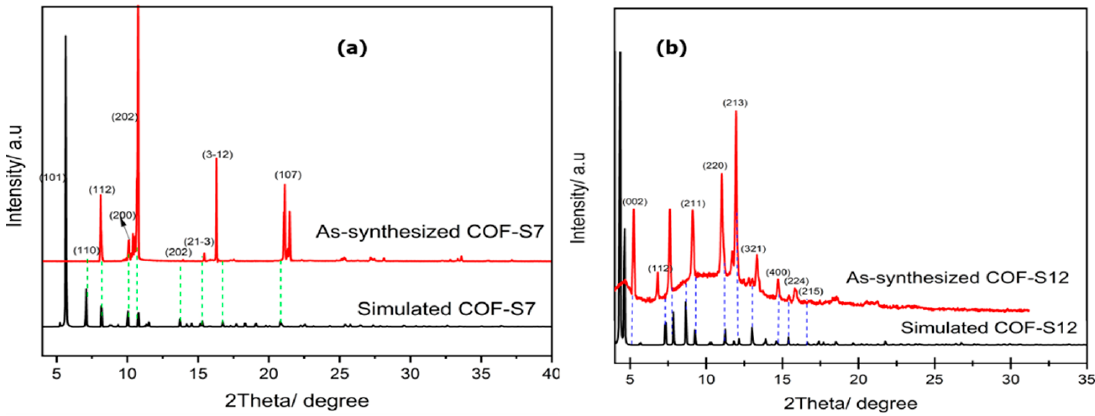
Figure 1. PXRD spectra of as-synthesized and simulated ( a ) COF-S7 and ( b ) COF-S12.